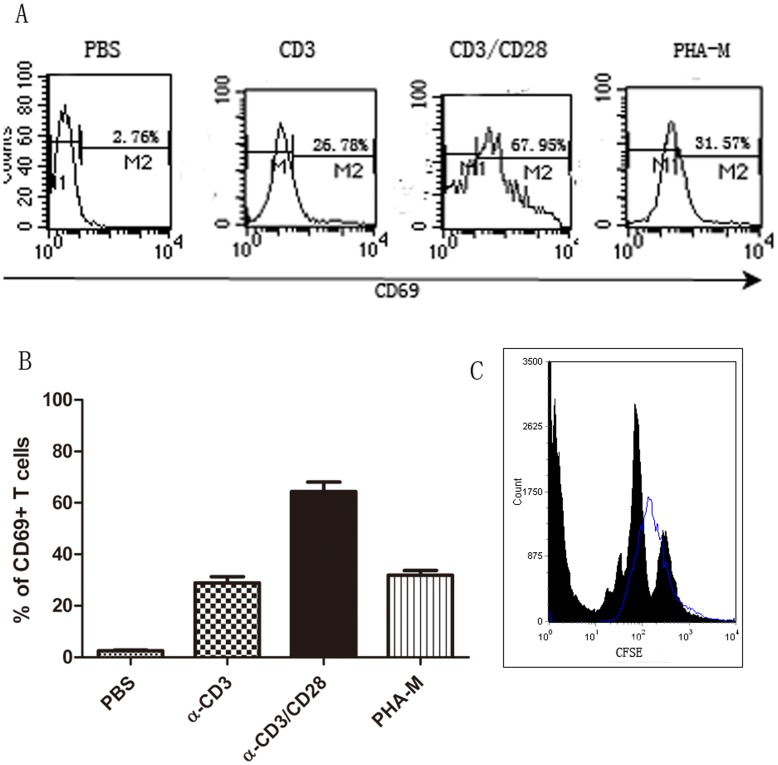
CD4+T cells stimulating assay by flow cytometry.
A and B, Purified naïve CD4+T cells were cultured in wells with PBS, anti-CD3 mAb alone (5 µg/ml), anti-CD3 mAb (5 µg/ml), plus anti-CD28 mAb (2 µg/ml), and PHA-M (10 ng/ml) as indicated. After 3 days culturing, the expression of CD69 was assessed by flow cytometry. The percentages represented positive CD69 populations after CD4+T stimulation. The histogram of a representative experiment is presented in A (blank line, CD69 staining). CD4+T cells stimulated by anti-CD3 Ab plus anti-CD28 Ab elevated CD69 expression by 67.95%, compared with PBS (2.76%), anti-CD3 alone (26.78%) or PHA-M (31.57%), displaying the most efficient T cells proliferation. The summary of 3 independent experiments is presented in B. C, Cell division of CD4+T cell subpopulations were measured by CFSE dilution on day 3 by flow cytometric analyses of CD3/CD28 stimulating cells. (blue line, Isotype control; blank, CD69 staining).